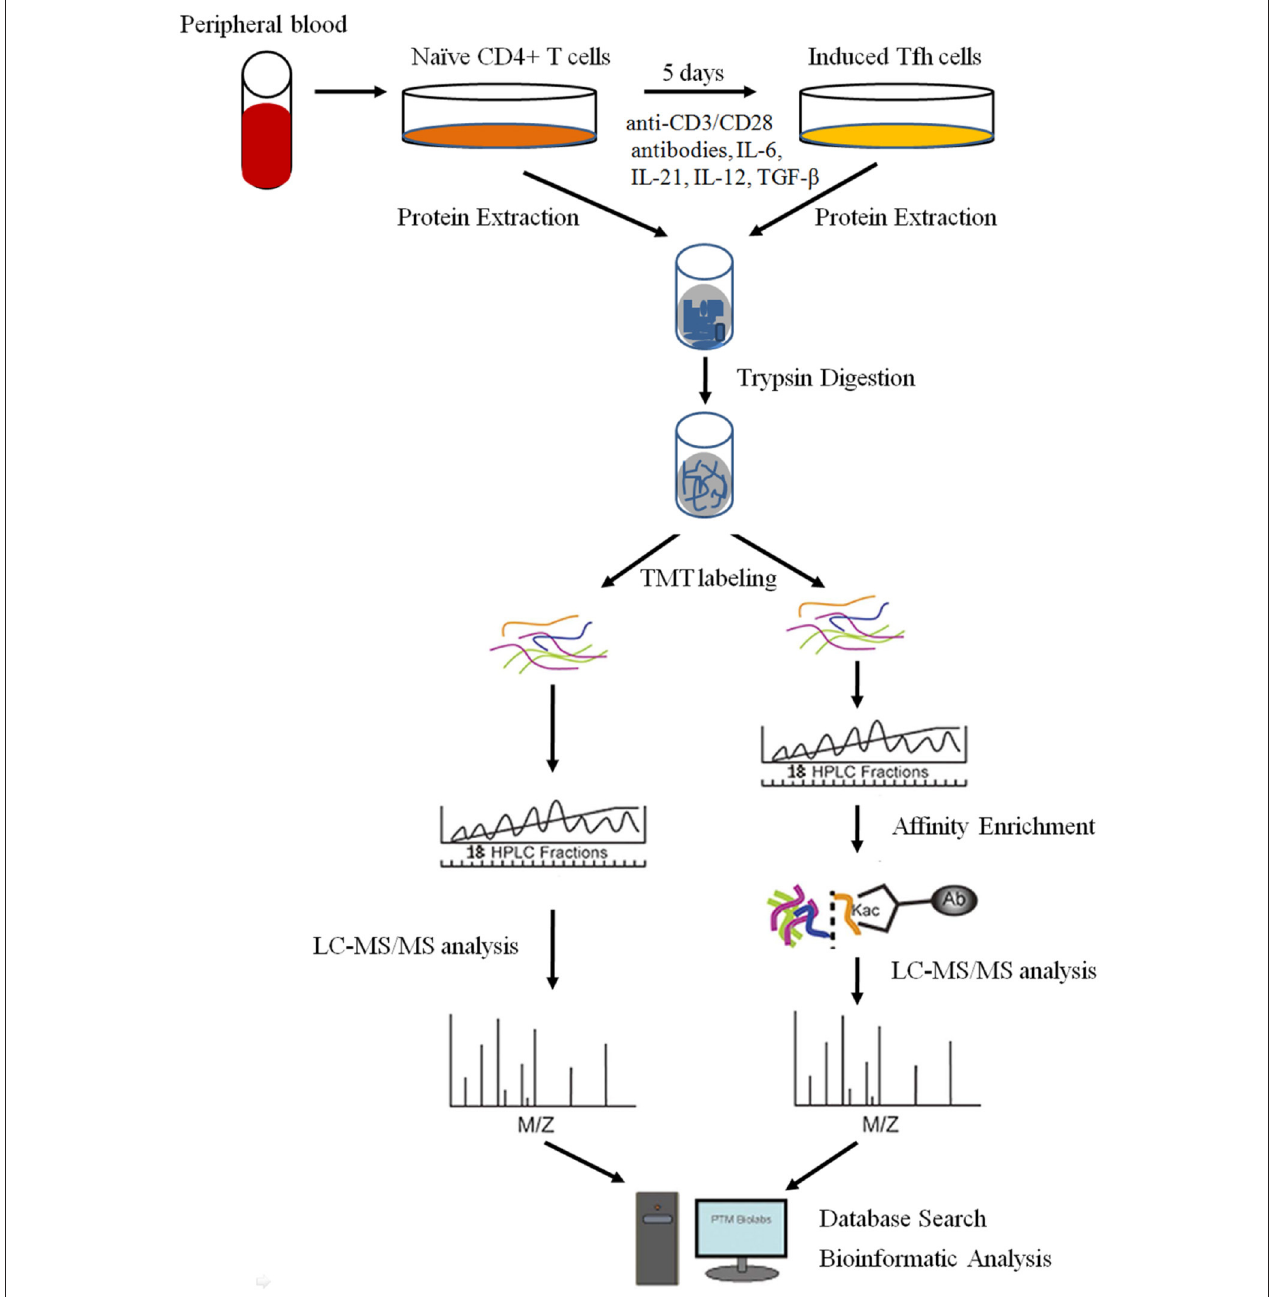
FIGURE 1 | The workflow for the quantitative analysis of global proteome and lysine (K) acetylome in naive CD4 + T cells and induced Tfh (iTfh) cells.